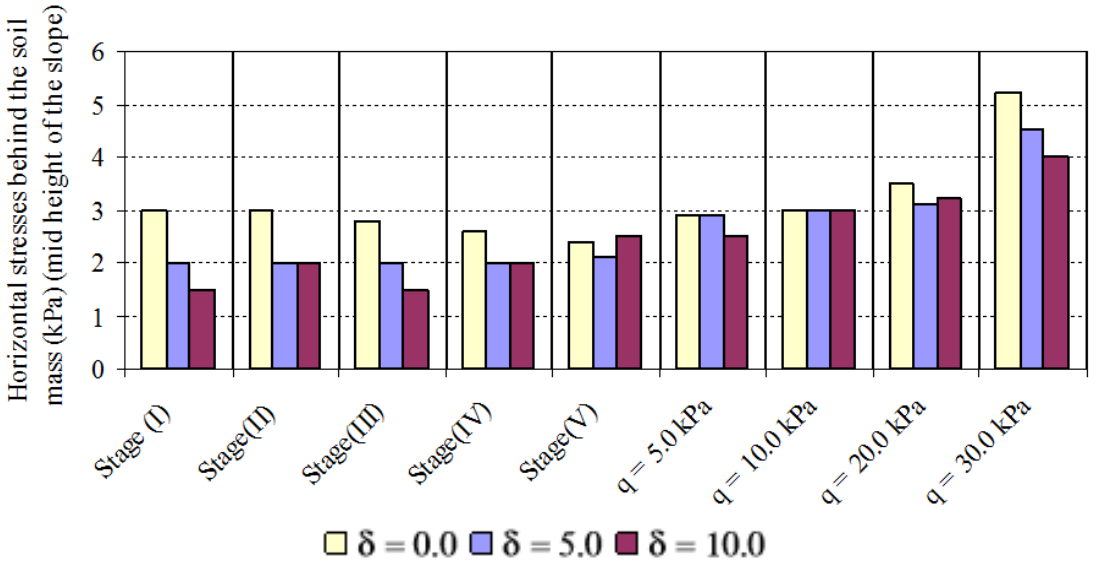
Figure 20. Influence of nail inclination on horizontal stresses behind the nailed soil mass at mid height of slope.